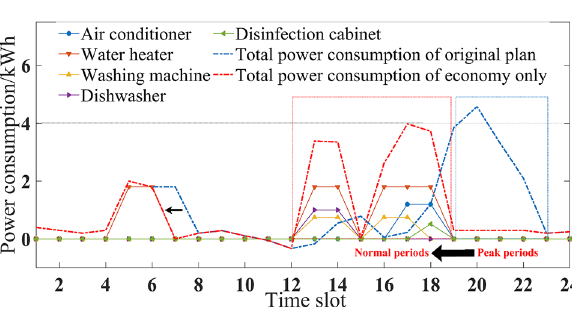
Figure 6. Power consumption plan aiming to minimize costs in